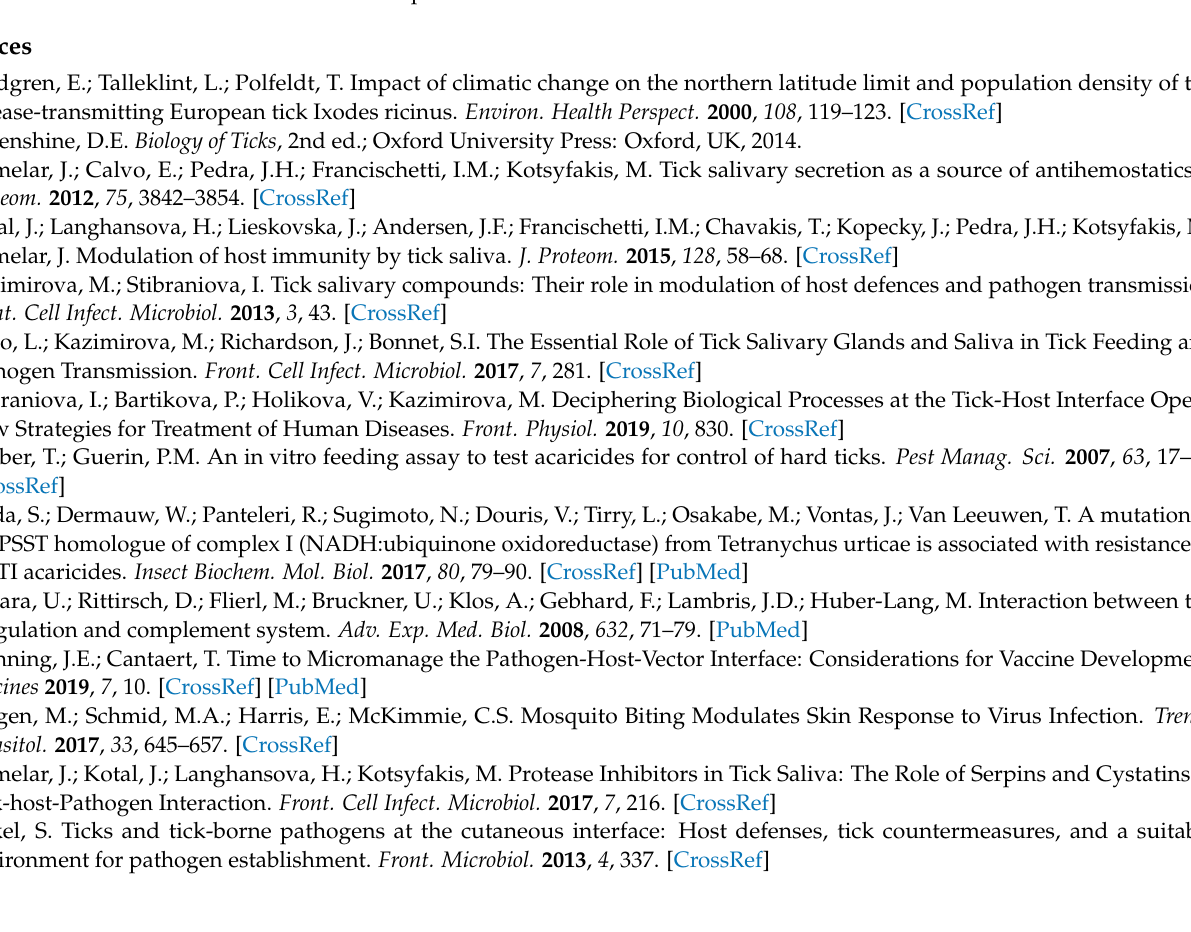
ure S3: CD spectrogram of Iripin-8; Supplementary Figure S4: Effect of Iripin-8 on T cell proliferation and neutrophil migration; Supplementary Figure S5: A ribbon diagram of two Iripin-8 symmetry- related molecules; Supplementary Figure S6: Ribbon diagram of Iripin-8 with highlighted molecules of PEG; Supplementary methods: Evolutionary analysis by the maximum likelihood